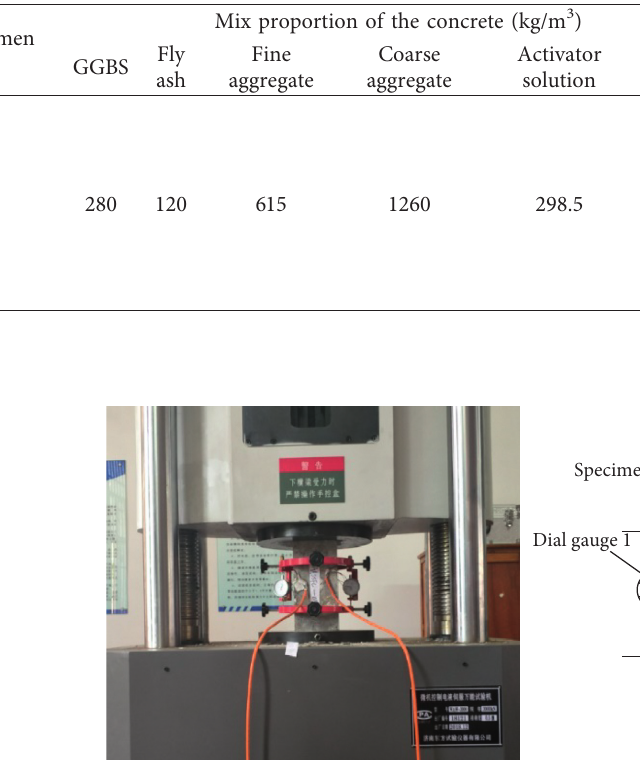
Table 2: Mix proportion design of steel fiber reinforced AASC.